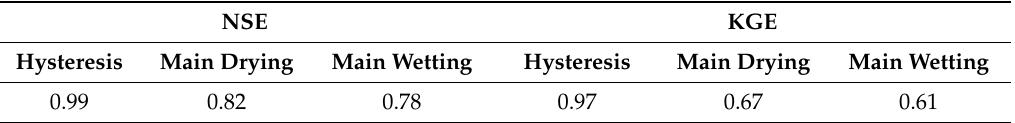
Figure 11. Hysteresis factor as a function of the parameter n v of the Van Genuchten model. Hollow circles represent data provided by literature datasets, and filled-in symbols were values calculated in the present investigation.